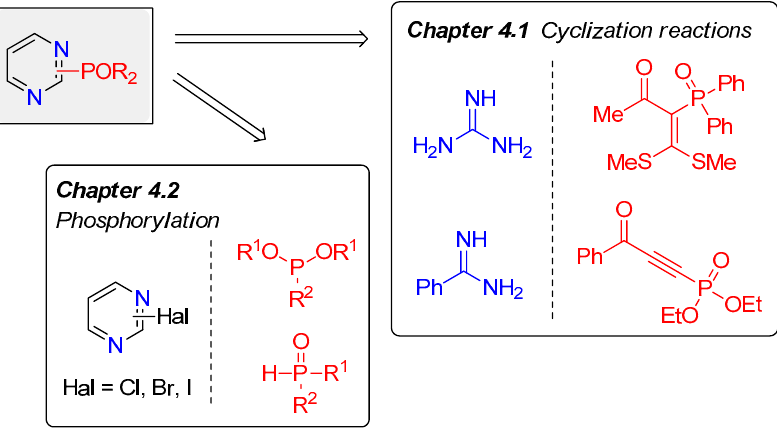
Figure 3. Approaches to synthesis of POR 2 -containing pyrimidines.